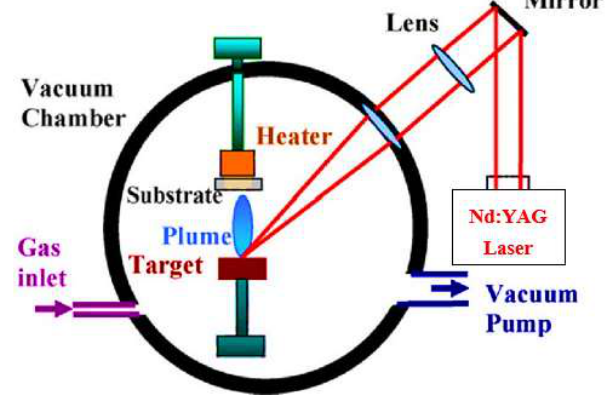
Figure 12: Schematic representation of the PLD